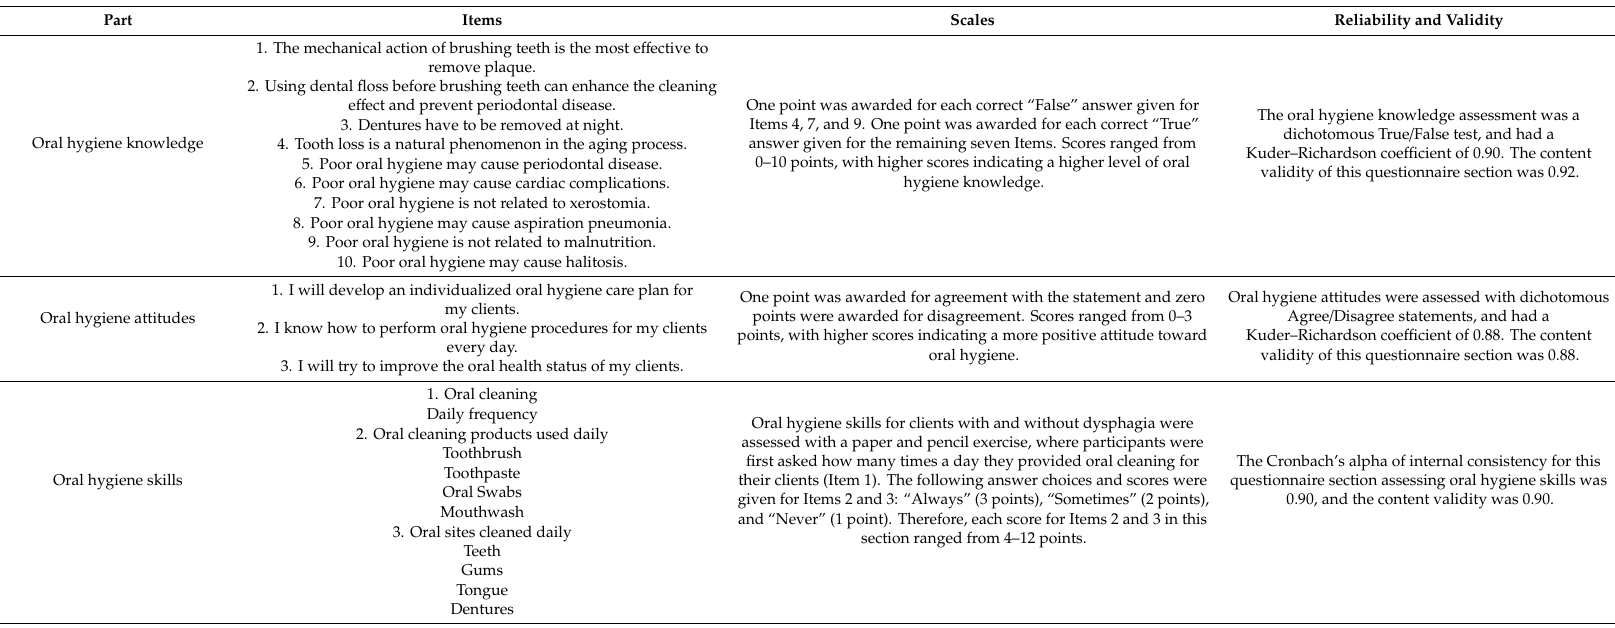
Table 1. The structured questionnaire assessing oral hygiene knowledge, attitudes, and